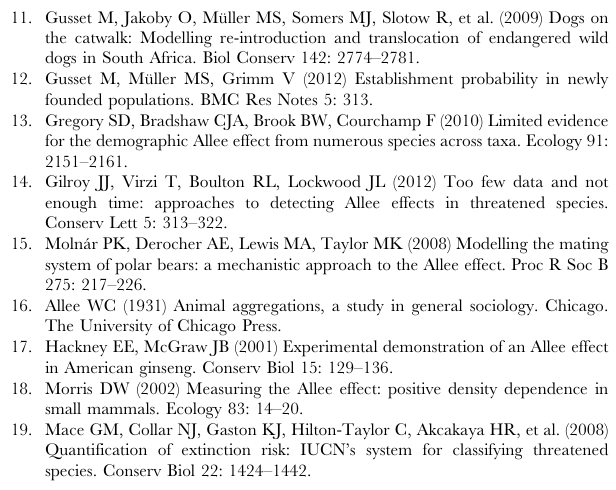
Figure S1 The impact of mate limitation on short-term population growth. The geometric mean population growth rate (cid:2) ll is shown for two projection intervals (15 years and 45 years) as a function of initial population density and operational sex ratio. Each panel considers the ‘‘old’’ population scenario, where all females and males are sexually mature adults (i.e., in stages 4 and 10, cf. Fig. 1) at the beginning of the projection, and no female is accompanied by dependent offspring. The operational sex ratio yielding maximal population growth as a function of initial population density is shown by a thick black line for each projection interval. Note that (i) population growth is reduced over a wide range of densities and sex ratios relative to the population